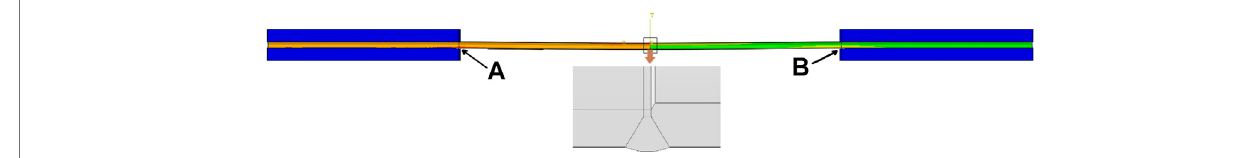
FIGURE 15 | Pipeline deformation diagram.